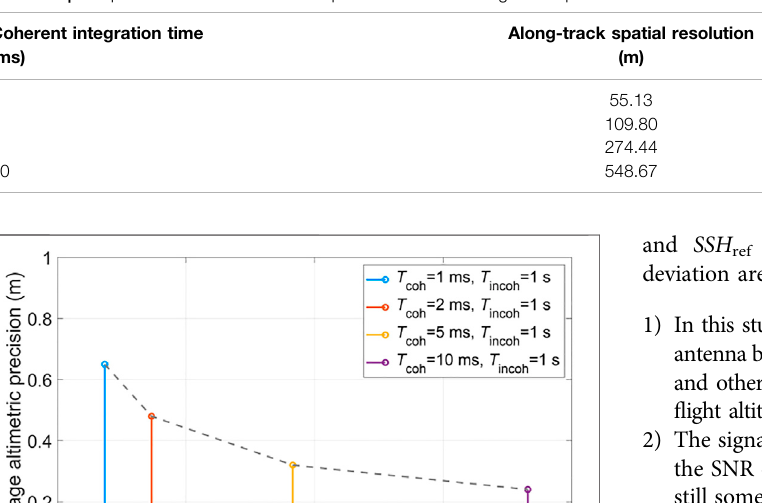
Along-track spatial resolution (m)